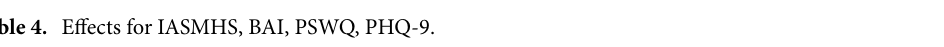
Table 4. Effects for IASMHS, BAI, PSWQ,